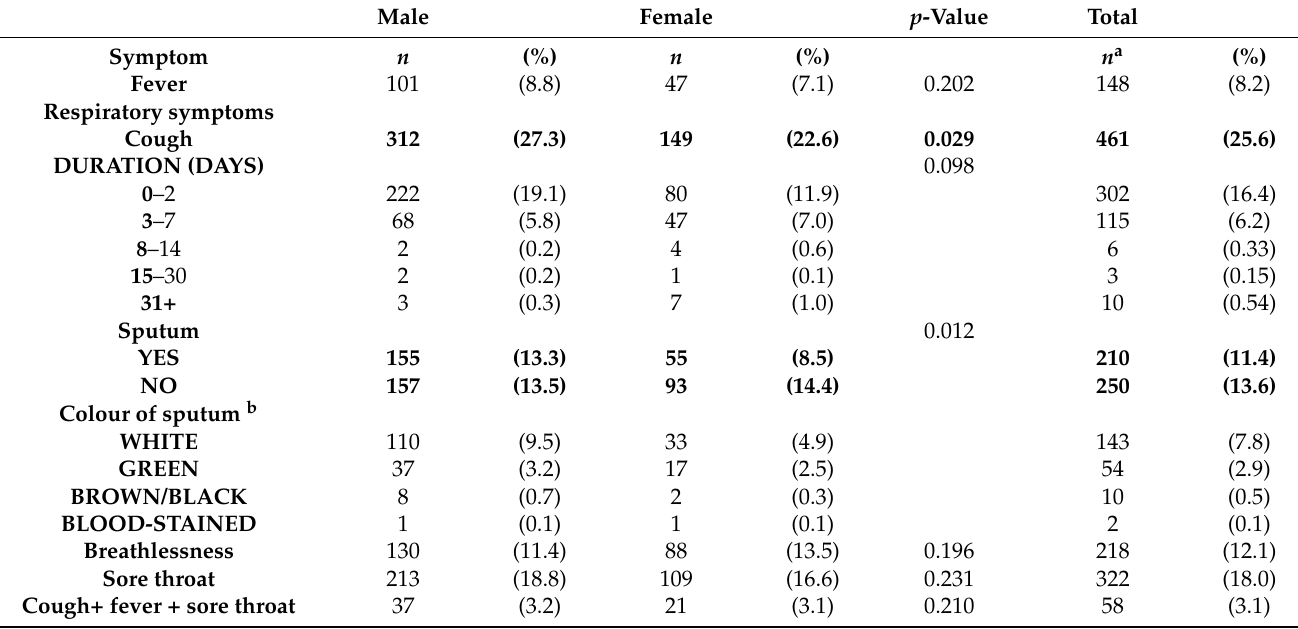
Table 2. Symptoms of potential respiratory infectious diseases in Arbaeen 2019 survey